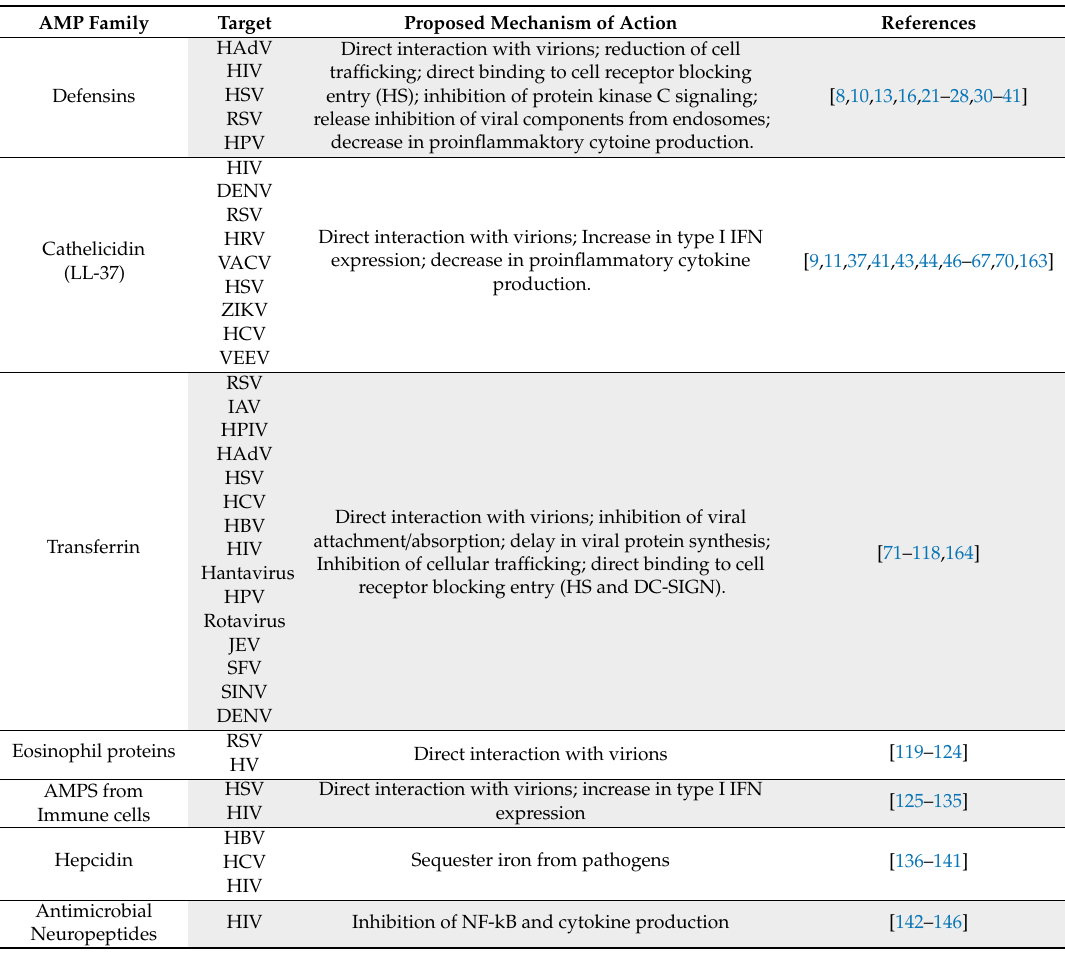
Table 1. Mechanisms of actions of antiviral